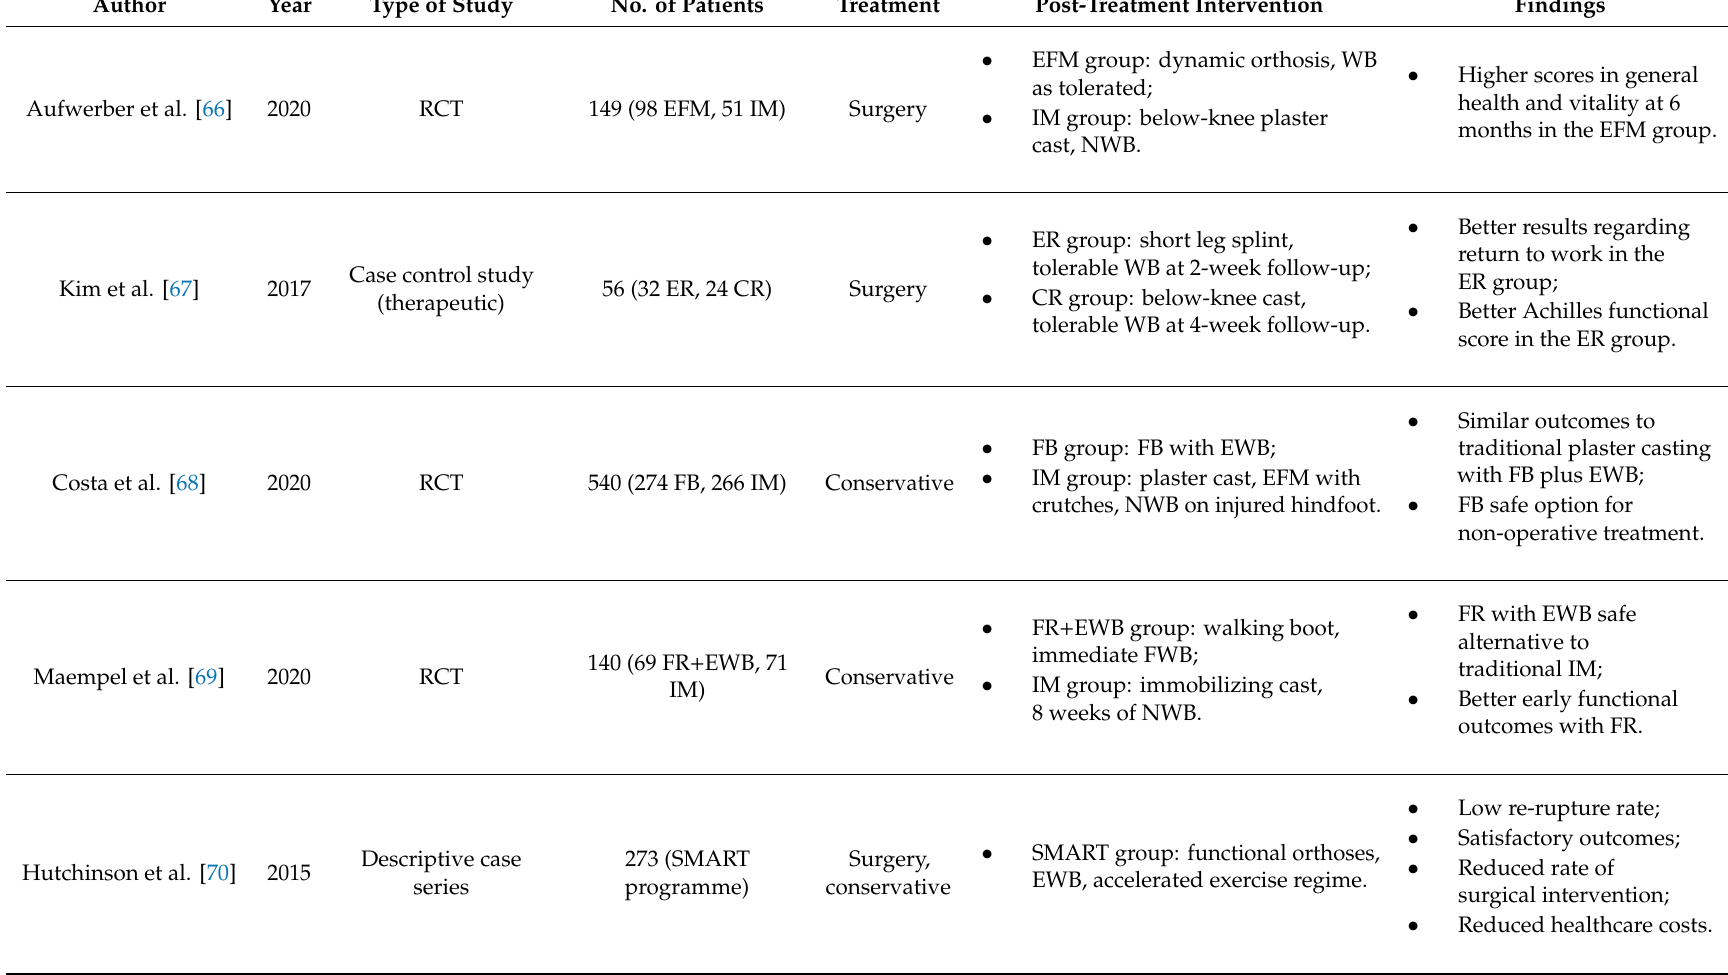
Table 1. Post-treatment interventions and